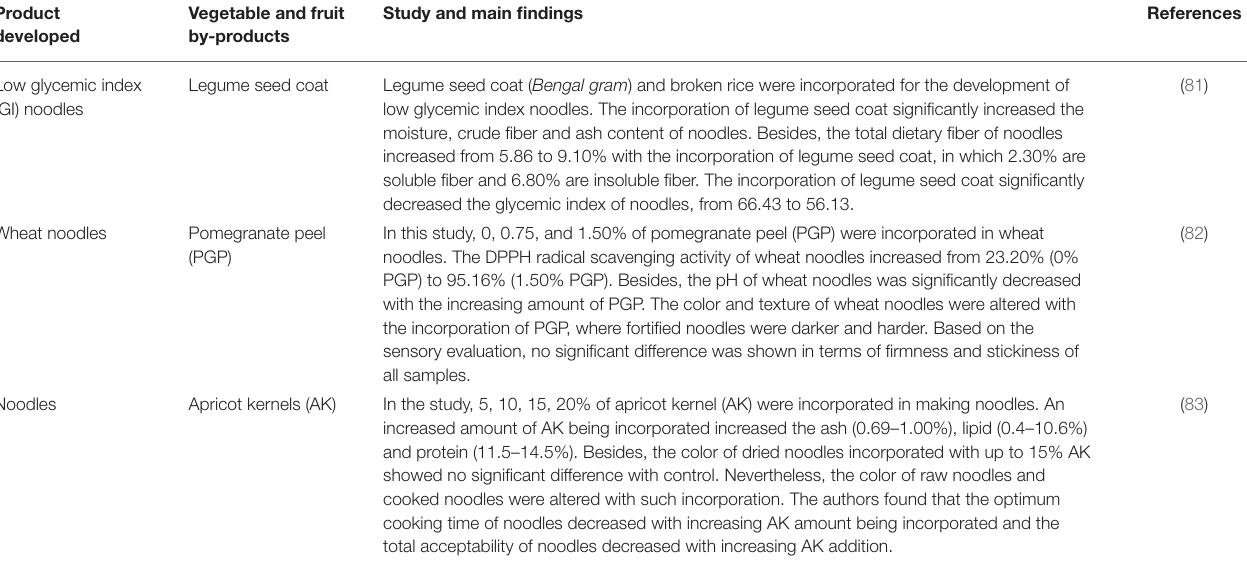
TABLE 3 | Study and main findings of vegetable and fruit by-products utilization as functional ingredients in development of